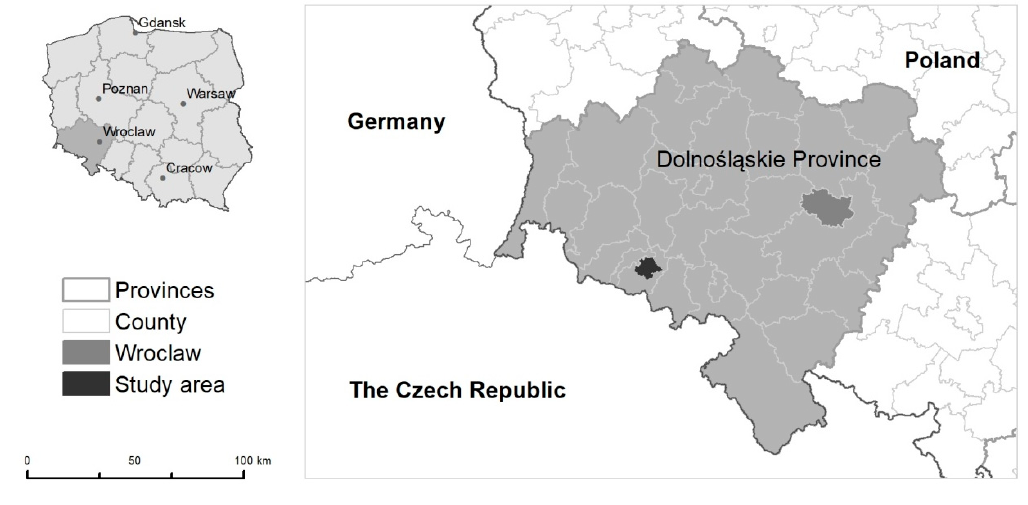
Figure 1. Locality of the object of the study.